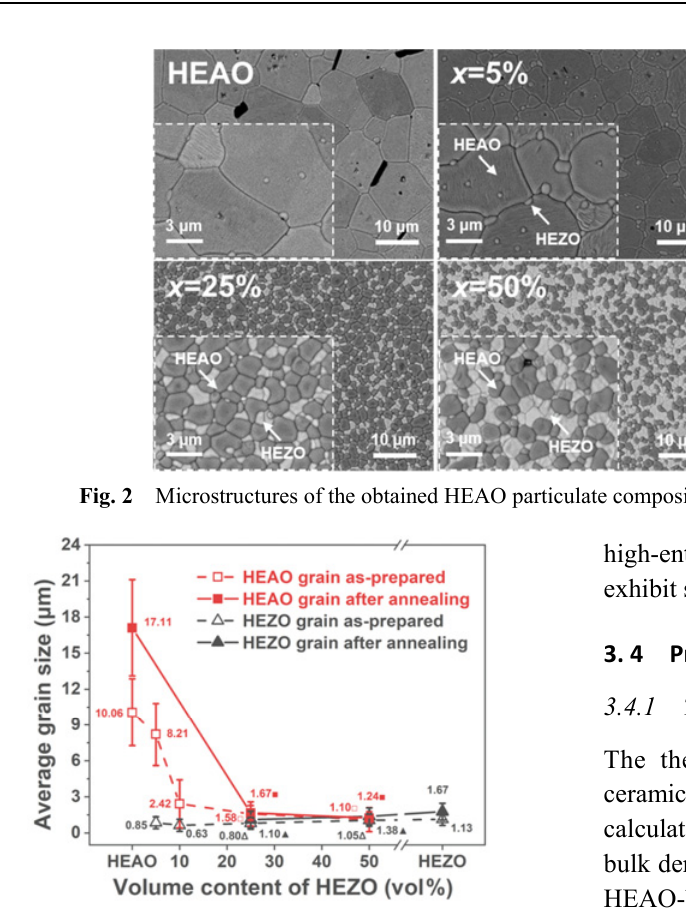
Fig. 3 Grain sizes of the as-prepared particulate composites and particulate composites after annealing at 1773 K for 20 h.